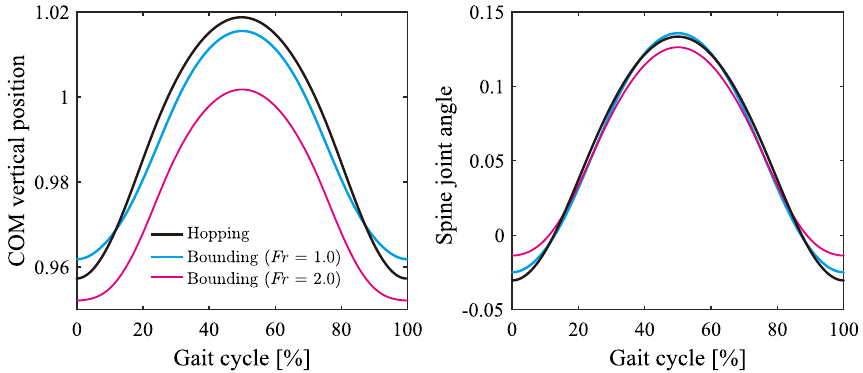
Figure 3. Comparison of COM vertical and spine movements between hopping and bounding in our previous ( averaged velocity )/ √ gL 0 indicates Froude number, where L 0 is model, modified from Kamimura et al. 33 Fr = the leg length of the